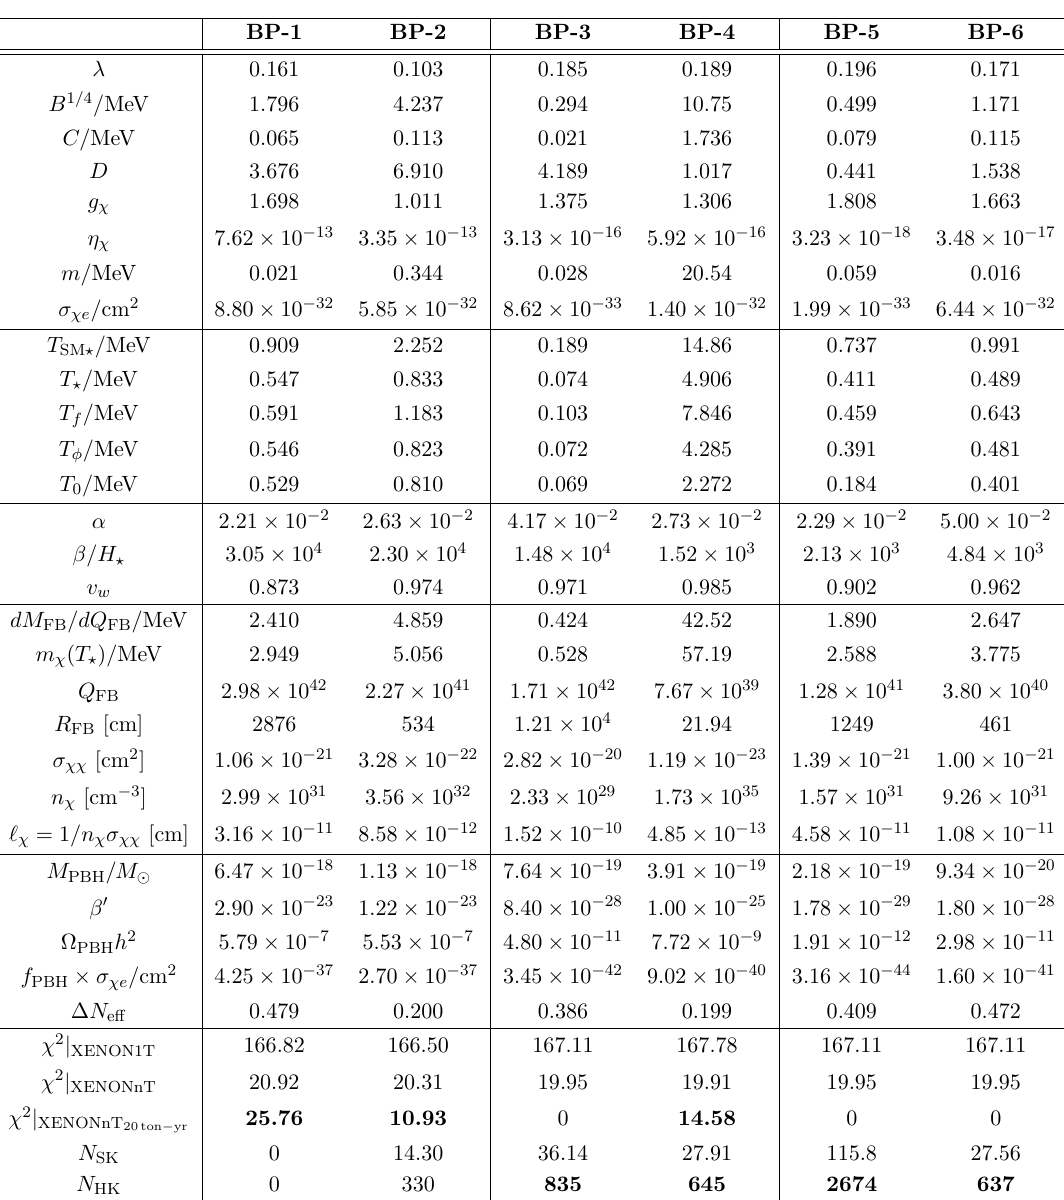
Table 1 . Benchmark points with A = 0 . 1 . The strength of the FOPT is defined by α , the ratio of the latent heat released and the radiation energy density at the time of the FOPT, and β − 1 is its duration. For the background only hypothesis, χ 2 The numbers in boldface correspond to a > 2 σ